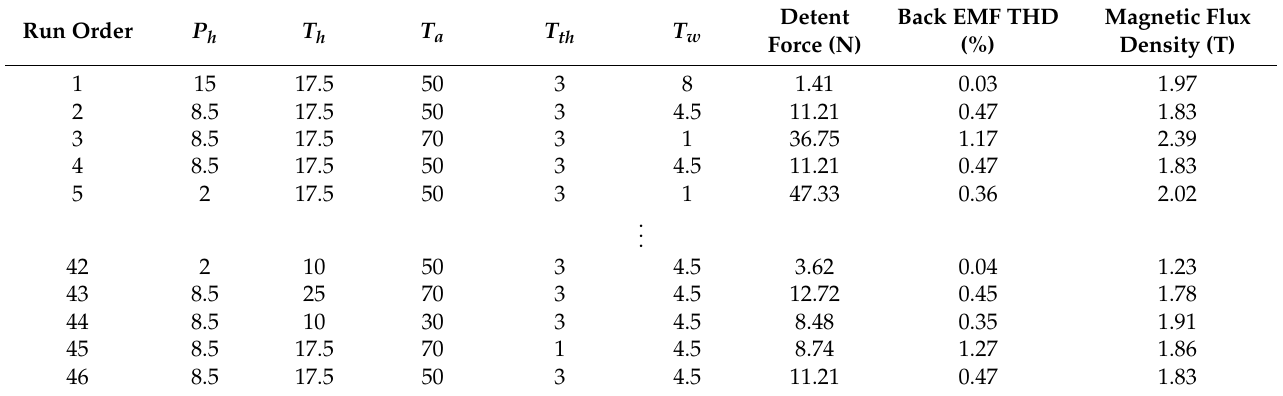
Table 4. Box–Behnken design and results for each process.